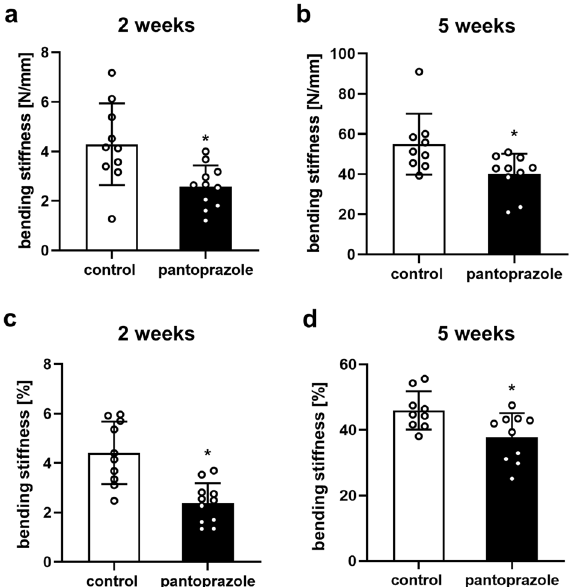
Figure 2. Biomechanical analysis of mice femora. Biomechanical analysis of bending stiffness 2 weeks ( a , c ) and 5 weeks ( b , d ) after fracture healing in controls (white bars) and pantoprazole-treated animals (black bars). Data are given in absolute values [N/mm] ( a , b ) and in percent to the contralateral, non-fractured femora [%] ( c , d ). Means ± SD; n = 9–12; *p < 0.05 vs.